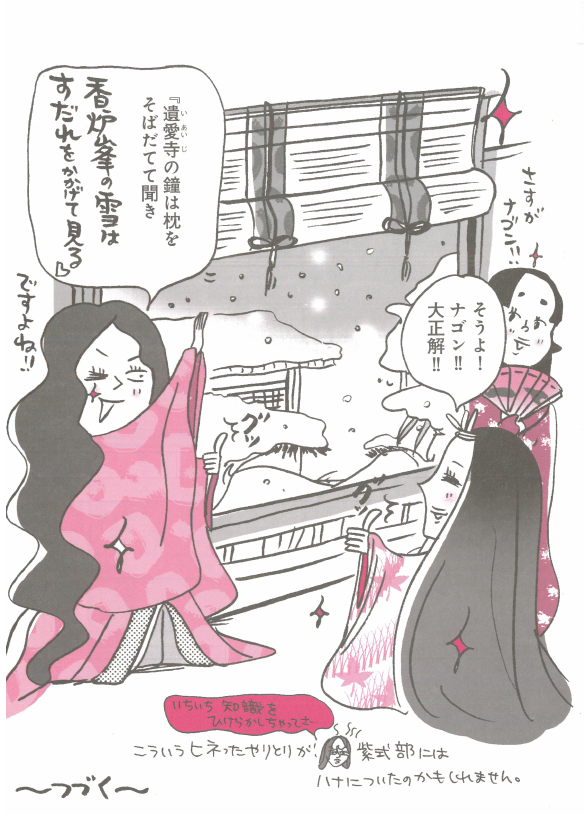
Figure 7. Sei argues for the importance for women to work outside the